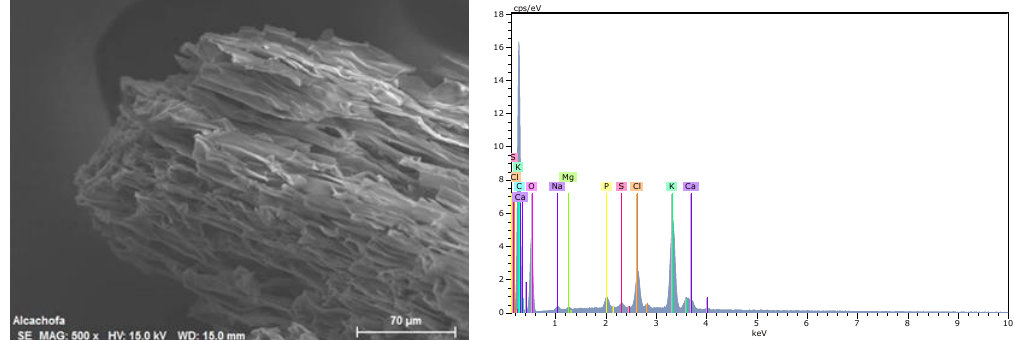
Figure 1. SEM image and EDS analysis of artichoke-agrowaste biomass.